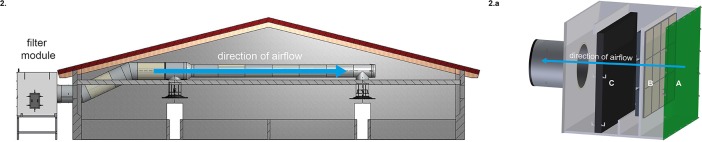
Distribution of fresh air into barn 1 and structure of the supply air filter modules of barn 1.(2.) This figure exemplarily illustrates the air influx for one supply air filter module. Five of these modules were installed at the left long side of barn 1. Each module was connected to a corresponding ventilation pipe along with two air distributors. The direction of airflow is indicated by a blue arrow. (2.a) Supply air filter modules were composed of: A—windshield, B—prefilters and secondary compact filters, C—adiabatic cooling device. Prefilter dimensions were 592 mm (length) x 592 mm (height) x 48 mm (width). Secondary compact filters sized 592 mm x 592 mm x 292 mm (see S1 Table). The direction of airflow is indicated by a blue arrow.